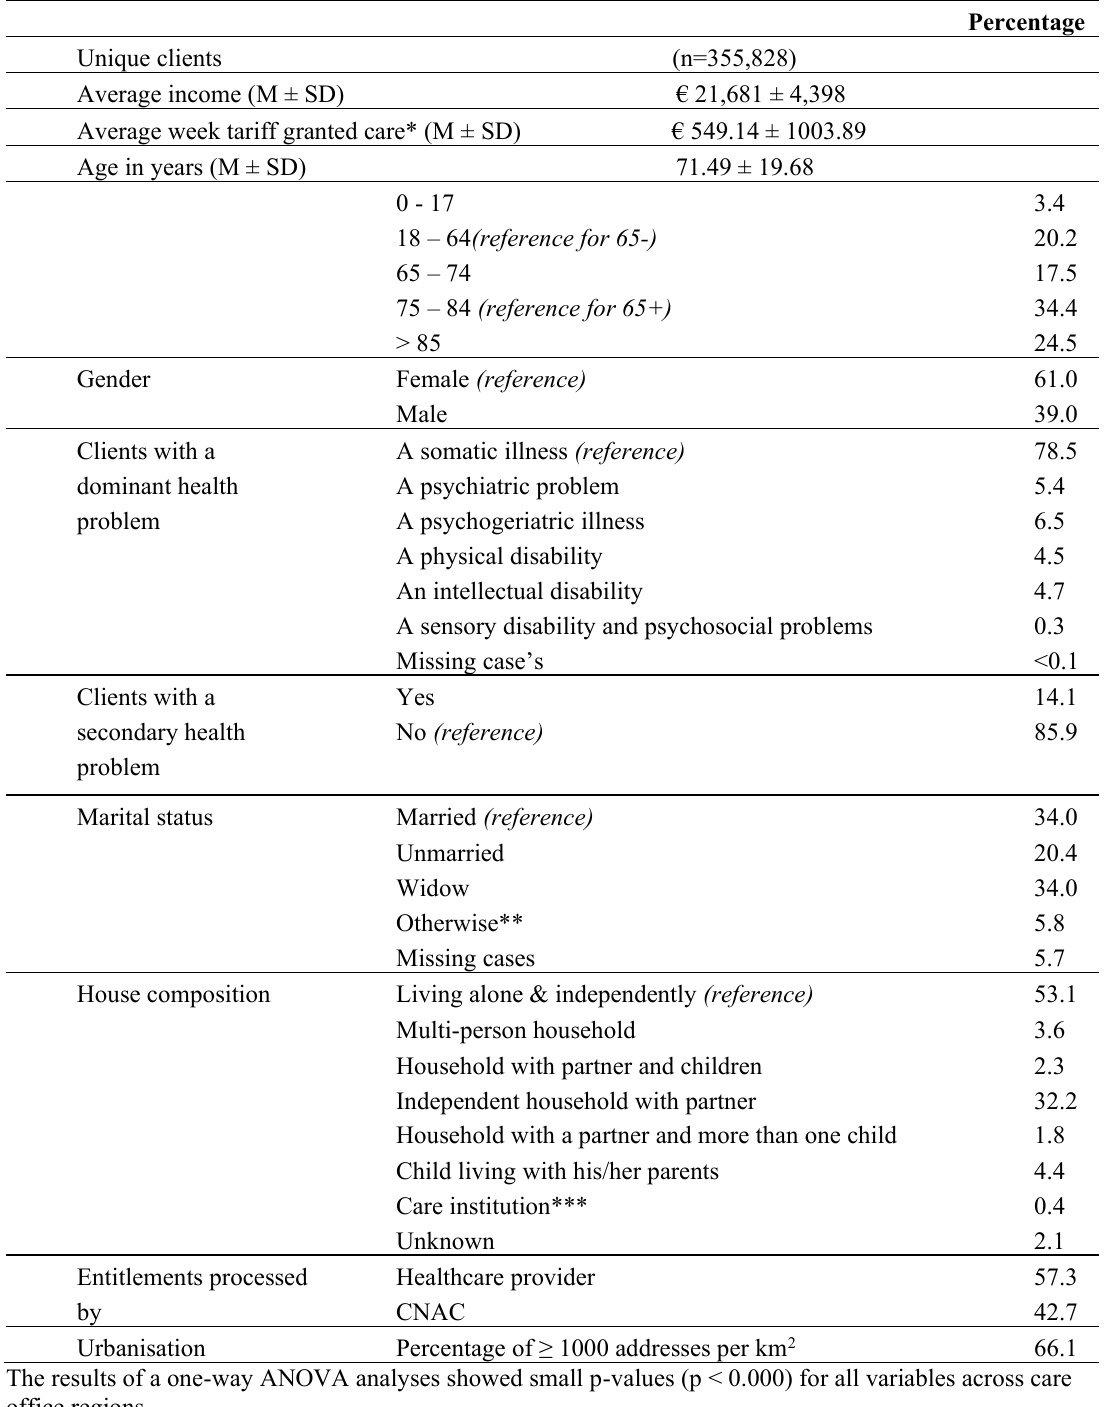
Characteristics and percentages of clients with an extramural care entitlement in the period July 2013 until June